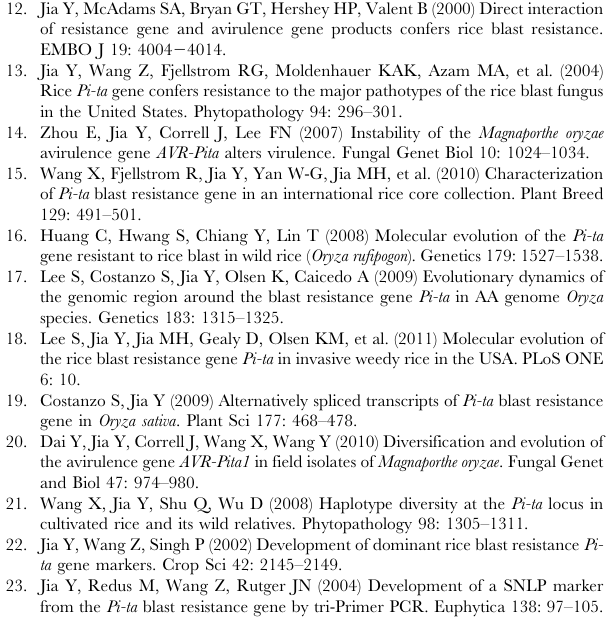
Table S4 Mapping profile for LJ mapping population